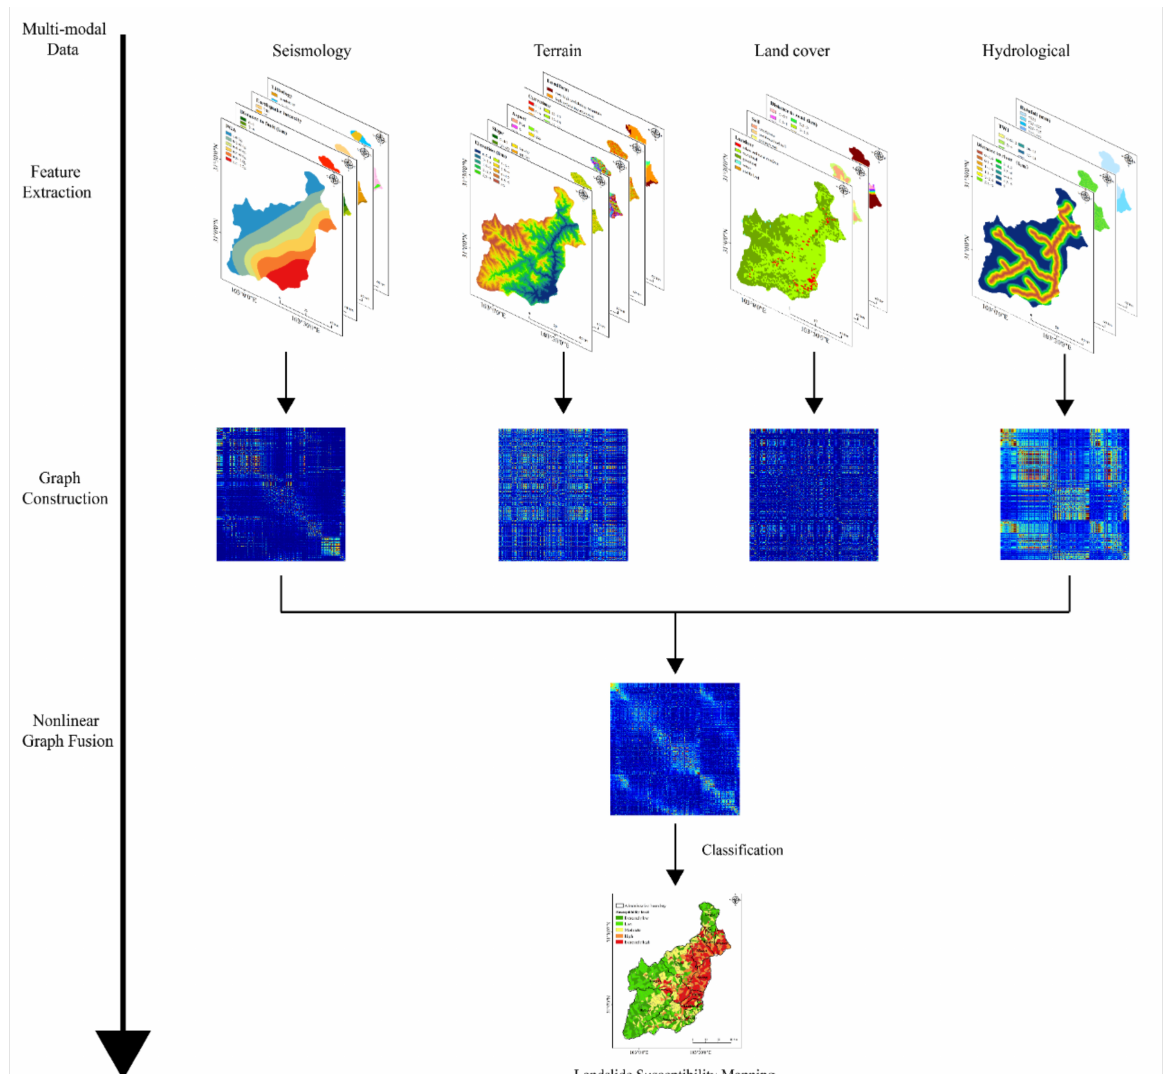
Figure 9. Workflow of LSM based on the graph theory and multi-modal